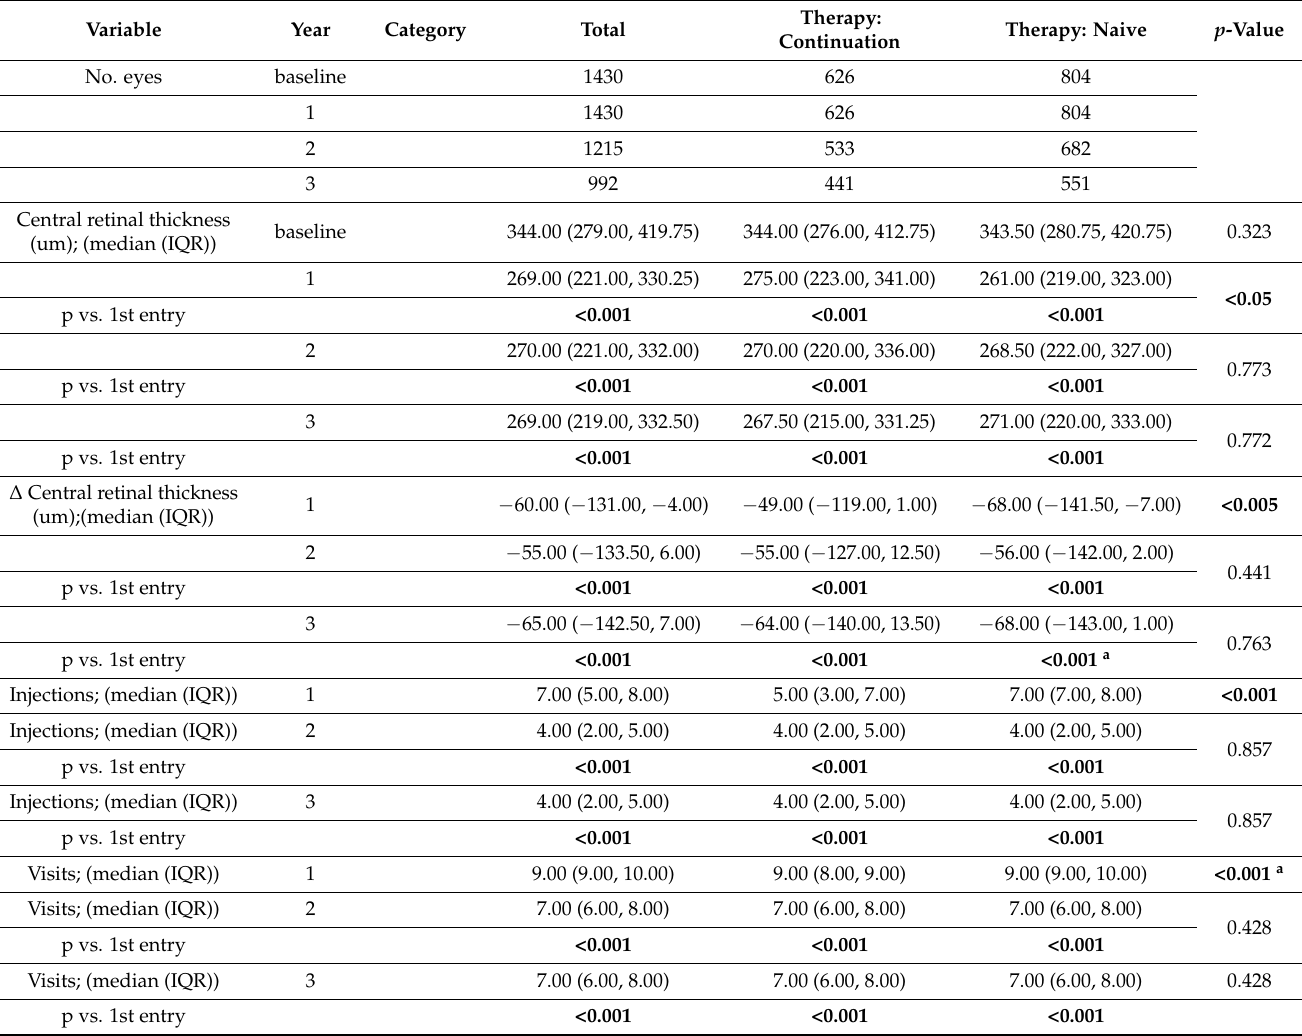
Table 3. Patients’ morphological